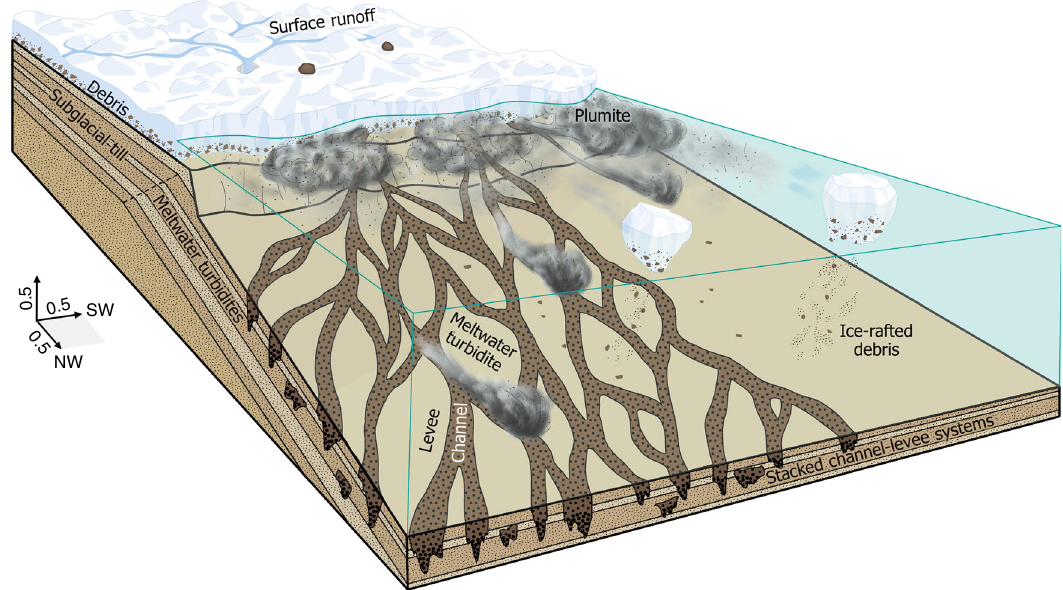
Fig. 7 Conceptual model for sedimentation during the last glaciation (MIS2). Meltwater turbidites and turbid-surface plumites are the dominating processes, and result in channel-levee systems on the North Sea Fan. Continuous sediment transport in water-rich fl ows build an up to 450 m thick sediment sequence in the time period of 23 to 19 ka. Dimensions are approximate, and given in